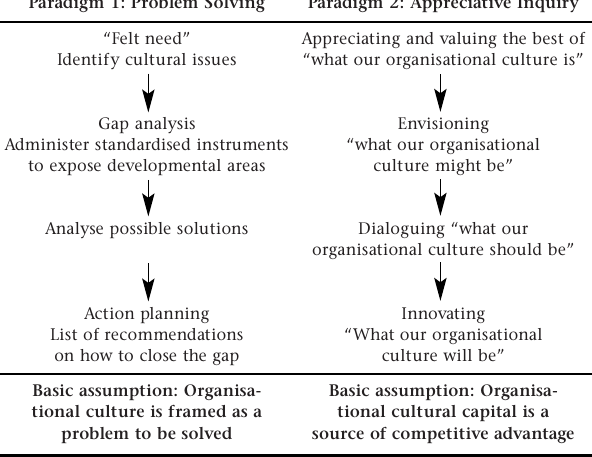
Figure 3: Adapted from Cooperrider and Whitney (2000, p.